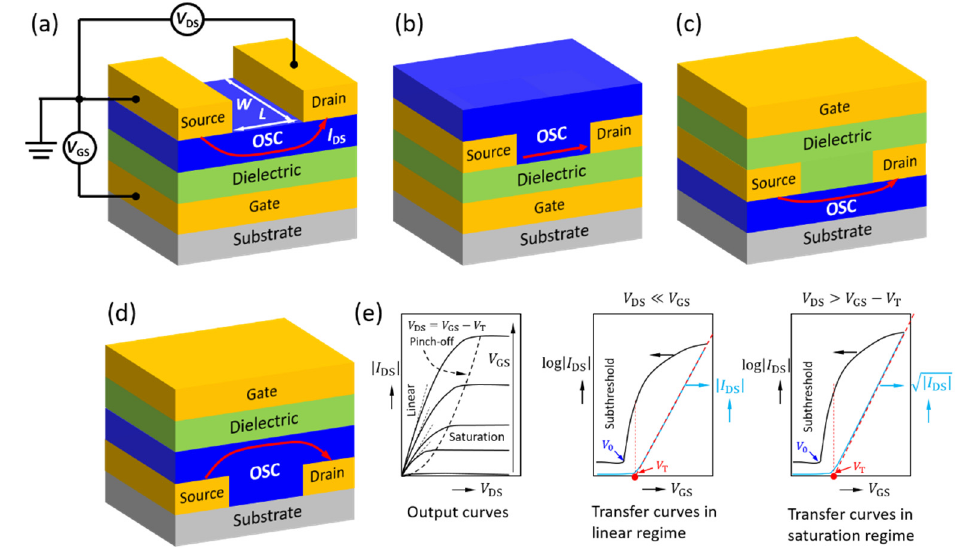
Figure 1. Four common OFET architectures: ( a ) bottom-gate top-contact (BGTC), ( b ) bottom-gate bottom-contact (BGBC), ( c ) top-gate top-contact (TGTC), and ( d ) top-gate bottom-contact (TGBC). Schematic output characteristics and transfer characteristics in the linear and saturation regimes of an OFET device are shown in ( e ), where V DS is the drain voltage, I DS is the drain current, V GS is the gate voltage, V T is the threshold (gate) voltage, and V 0 is the onset (gate) voltage. The red arrows in ( a – d ) indicate the current flow in the channel.